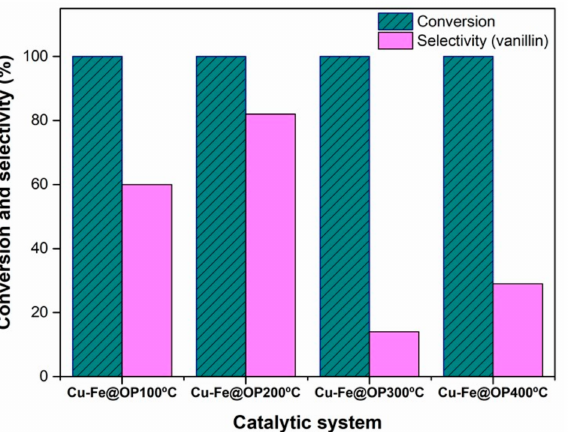
Figure 5. Catalytic performance of Cu-Fe@OP materials in the oxidation of trans-ferulic acid into